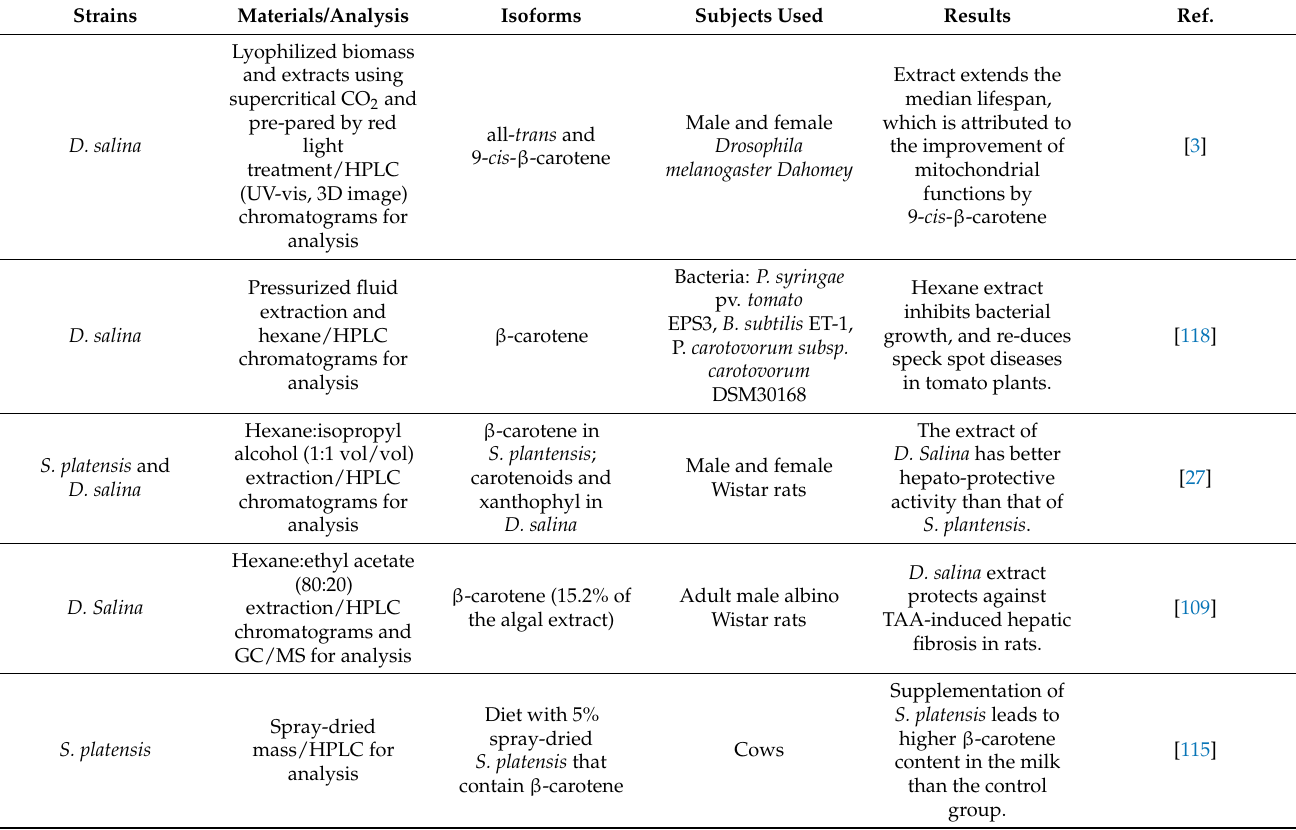
Table 3. The organic solvent extraction is still the main extraction method that is used in 10 articles [27,28,109–111,113,114,116–118]. HPLC is used in majority of these studies (9/13) to analyze the extract and determine the presence of β -carotene and other carotenoids and bioactive compounds [3,27,109,111,114–118]. One article used supercritical carbon dioxide extraction to obtain carotenoids, identified the presence of β -carotene isoforms, an- alyzed their biological activities, and determined the underlying functional mechanism [3]. The presence of β -carotenes isoforms is attributed to the extract’s ability to extend the drosophila lifespan [3]. Two articles directly used freeze-drying microalgae powder for research [112,115]. It appears that all these studies only included total carotenoids from microalgae, which the biological activities can be attributed to. Although the presence of β -carotene in the extracts or microalgae mass was confirmed, the purified β -carotene from microalgae has not been used and studied. Therefore, whether the biological activity really can be attributed to β -carotene is still an open question. The synthetic β -carotene is all- trans , which is considered less biologically active than the cis - β -carotenes [119–121]. The naturally extracted β -carotene contains both all- trans and cis isoforms, which have a higher market prospect and value than the synthetic ones [122,123]. Clearly, future studies using purified β -carotene from microalgae are anticipated and worth being investigated. Table 3. Microalgae studies that included extraction methods, identified β -carotenes, and determined their biological activities in cells or animal models at the same